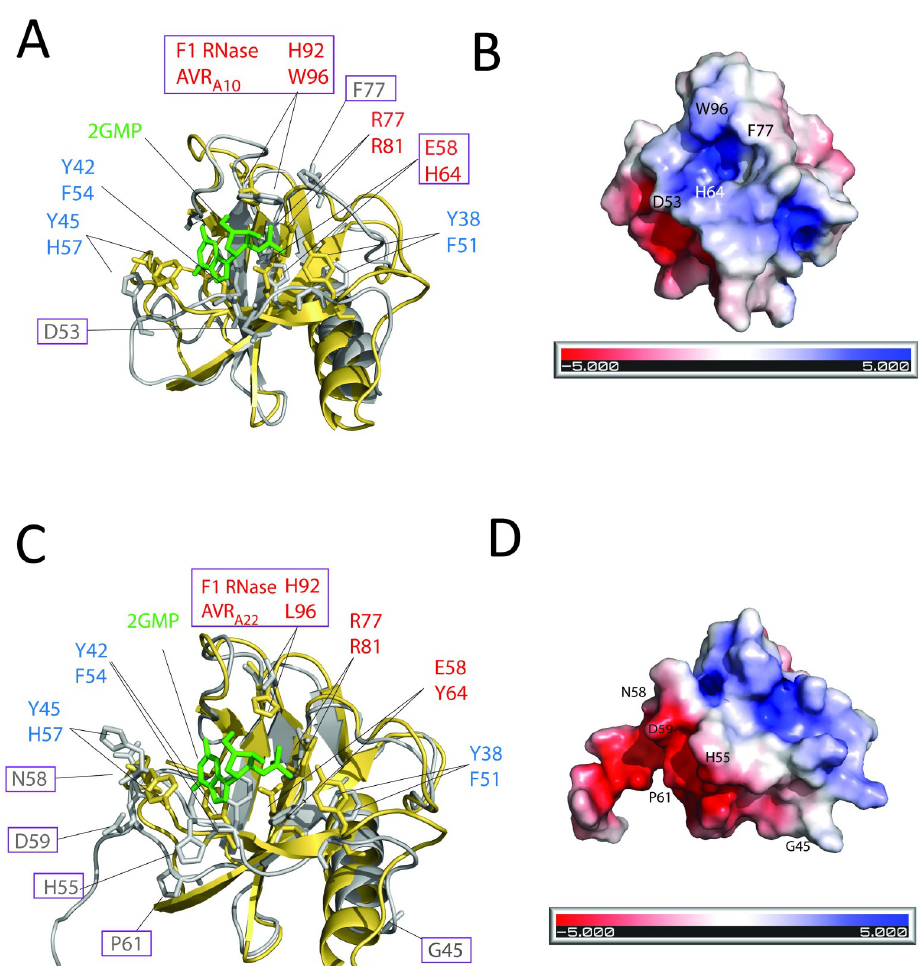
Fig 11. The location of amino acid residues in AVR A10 and AVR A22 that determine MLA10 and MLA22 recognition specificities. (A and C) show structural superimposition of the crystal structure of Fusarium moniliformis RNase F1 (yellow) and IntFOLD version 5.0 structural predictions of AVR A10 or AVR A22 (grey). Depicted in green is the F1 RNase ligand 2’-guanosine monophosphate (2’ GMP); residues of the F1 RNase catalytic triad and corresponding AVR A residues are depicted in red; residues of the F1 RNase RNA binding pocket and corresponding AVR A residues are shown in blue. The residues of AVR A10 and AVR A22 required for specific MLA10 and MLA22 recognition as determined in Figs 8–10 are framed with a purple rectangle. (B and D) Predicted electrostatic surface potential of the AVR A10 and AVR A22 effector surface calculated using Adaptive Poisson Boltzmann Solver (APBS) [67]. The residues of AVR A10 and AVR A22 required for specific MLA10 and MLA22 recognition as determined in Figs 8–10 are indicated. Below is a scale bar of the electrostatic potential (red = negative charge, white = neutral charge, blue = positive charge).